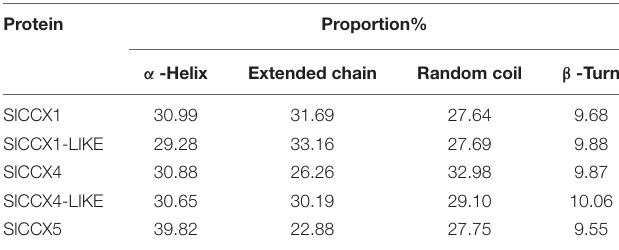
TABLE 2 | Secondary structures analysis of the SlCCXs